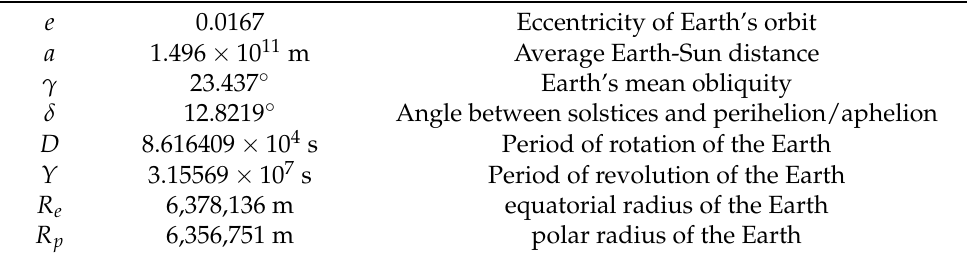
Table 1. Fundamental astronomical parameters for planet